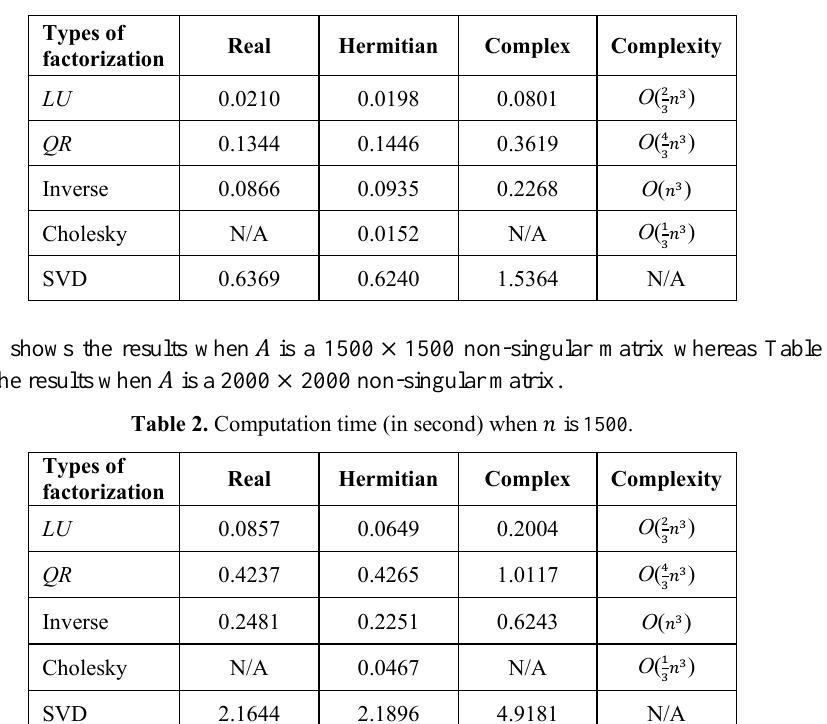
Table 1. Computation time (in second) when 𝑛 is 1000 .